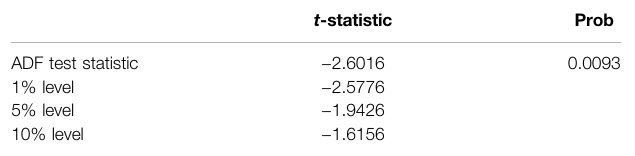
TABLE 3 | Result of the cointegration test for US dollar/UK pound. TABLE 4 | Result of the cointegration test for US